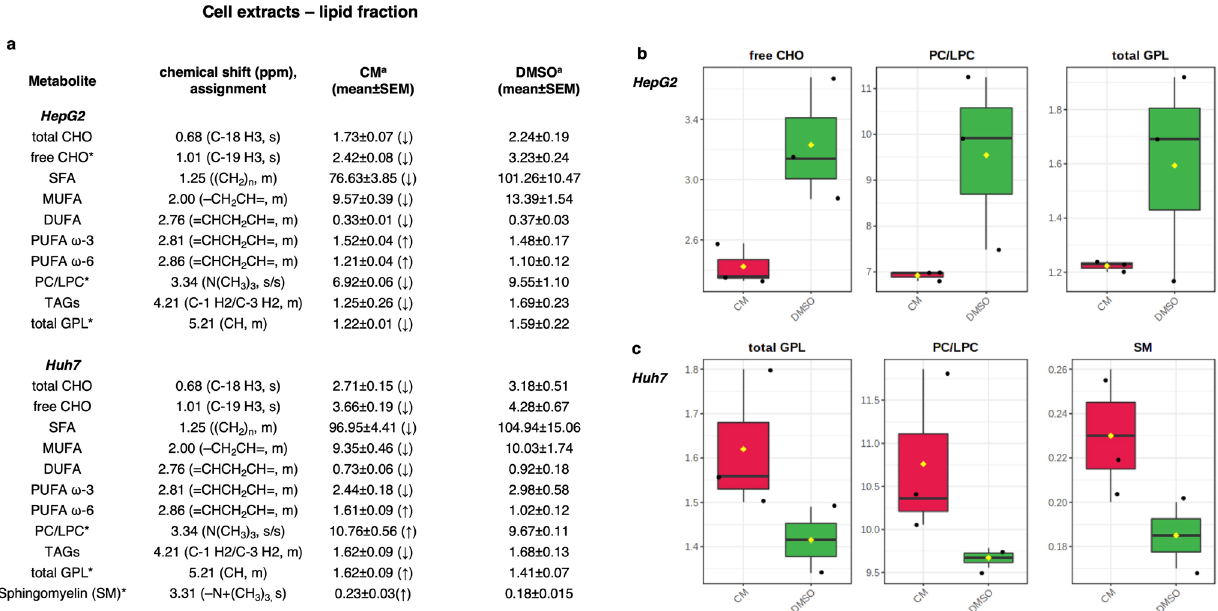
Figure 8. ( a ) Quantitative comparison of metabolites found in cell lipid extracts. Mean and relative standard error mean refers to the relative integrals of metabolites, determined from lipid cell extract 1D 1 H-NMR spectra of each group (CM and DMSO treatments). Letters in parentheses indicate the peak multiplicities ( s singlet, d doublet, dd doublet of doublet, q quartet, m multiplet). *A p -value threshold of 0.05 was obtained from t-test analysis. ( b , c ) Box-and-Whisker plots illustrating the significant metabolites trend grouped according to CM Crithmum maritimum treatment, DMSO DMSO treatment , derived from the 1 H-NMR spectra of ( a ) HepG2 and ( b ) Huh7 cell lipid